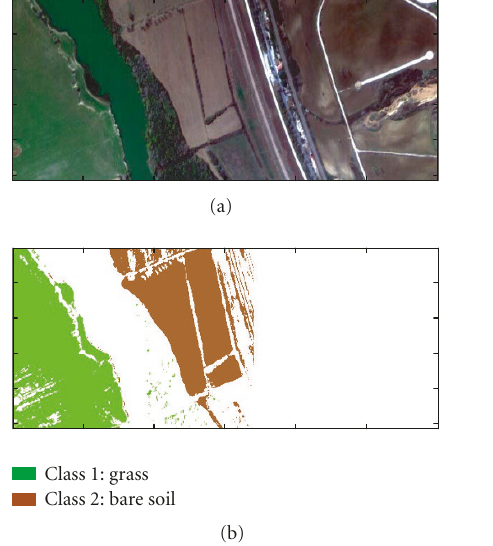
Figure 1: (a) RGB representation of the analyzed scene; (b) back- ground classes considered.